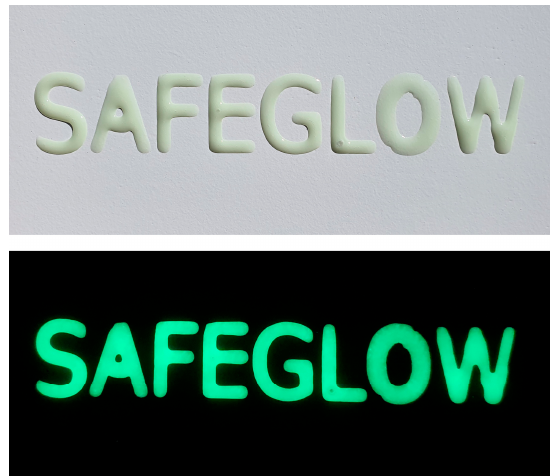
Figure 13. Real-life test of the pigment–organic matrix system prepared with 33% F pigment.